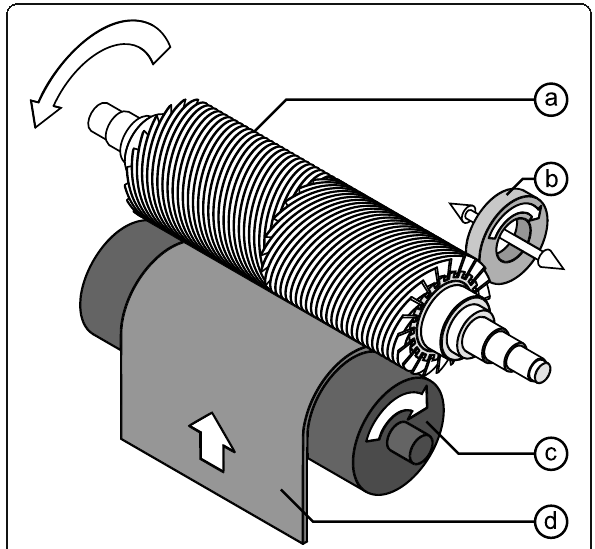
Fig. 1 Basic components of a shaving machine with indicators for direction of movement. a Knife roller. b Grinding wheel. c Support roller (chromium roller). d